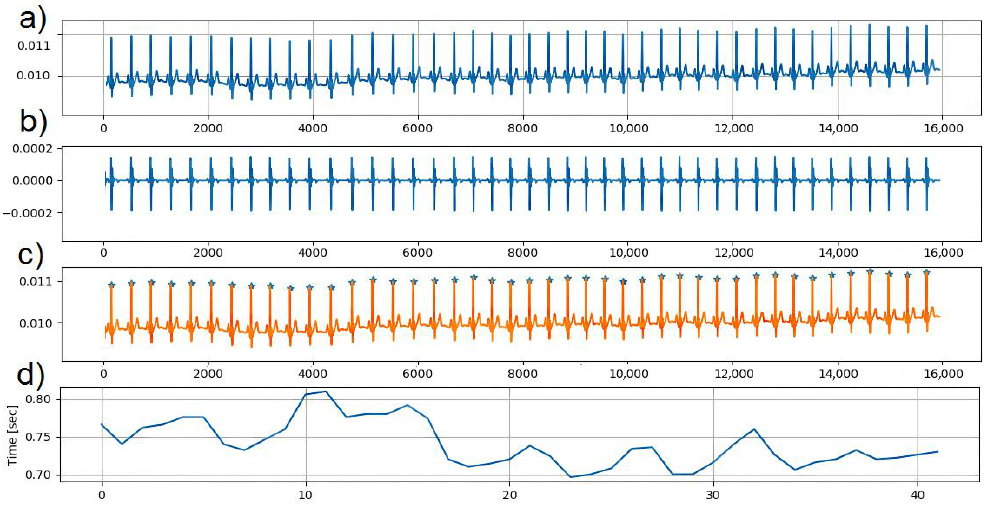
Figure 15. ECG signal acquired.